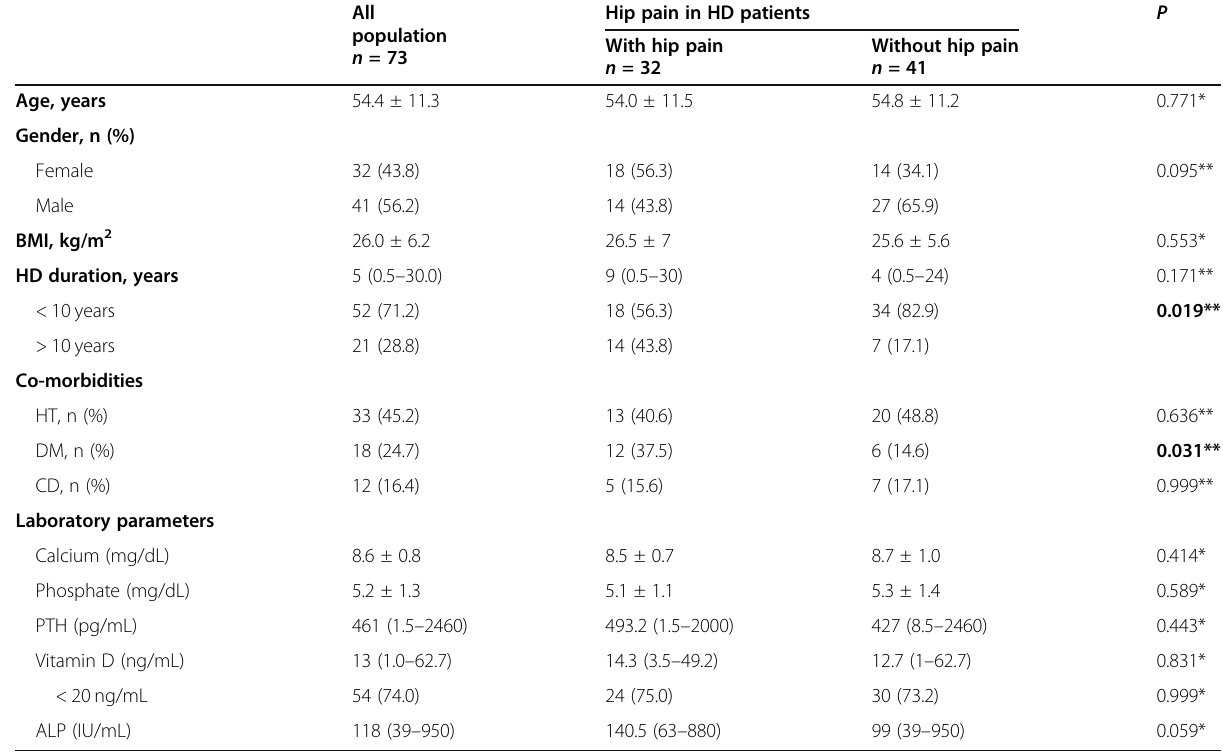
Table 1 Demographic and clinical characteristics of the hemodialysis patients